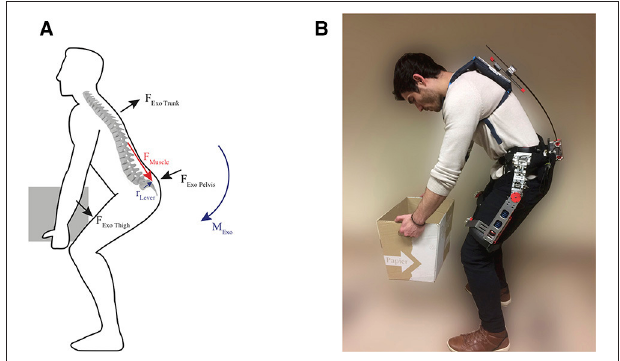
FIGURE 1 | Back muscle forces and exoskeleton forces and moments (A) . In order to balance the gravitational forces acting on on the trunk, the back muscles ( F Muscle ) contract. Since these forces act over a small lever arm of only a few centimeters ( r Lever ), almost parallel to the spine, the spine is subject to large compression forces. Exoskeletons aim at reducing these forces, by applying forces on the trunk ( F ExoTrunk ), pelvis ( F ExoPelvis ), and thigh ( F ExoThigh ). Together they produce an extension moment ( M Exo ); Passive spexor exoskeleton (B) . The exoskeleton unloads the back by applying a force at the torso, pelvis, and the thighs. The user has a large range of motion, when wearing the passive exoskeleton, due to advanced misalignment compensating mechanisms like the flexible beams in parallel to the spine. Written informed consent was obtained from the participant to publish this